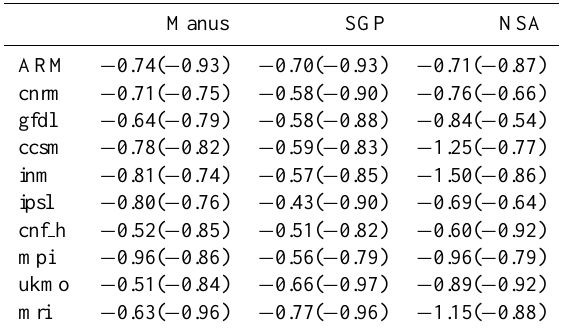
Table 3. Slope and correlation coefficient (in parentheses) between cloud cover and cloud transmissivity based on ARM data and nine GCMs results over three ARM